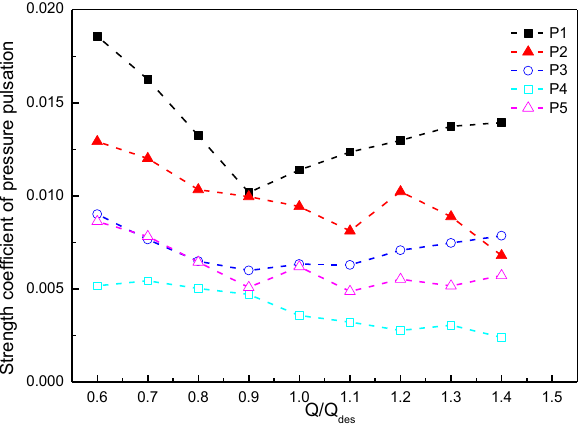
ffi cient under di ff erent flow conditions. Figure 17. Comparisons of pressure fluctuation intensity coefficient under different flow